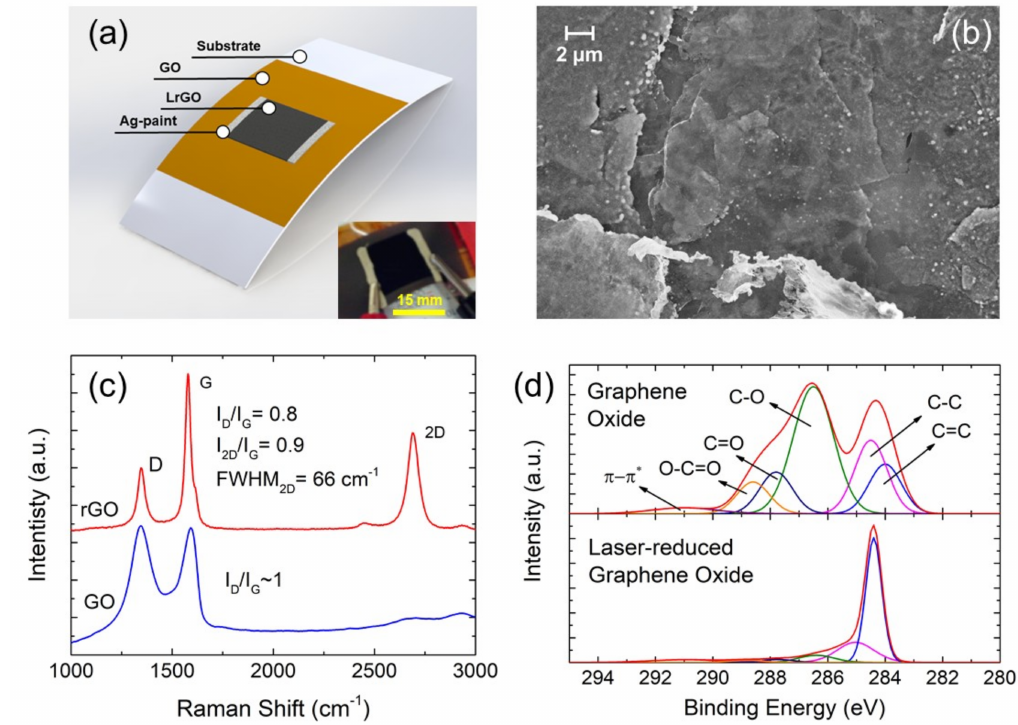
Figure 1. ( a ) Schematic diagram of the laser-reduced graphene-oxide (LrGO) heaters. Inset shows an actual picture of one of the LrGO heater (scale bar: 15 mm). ( b ), SEM image of a laser-reduced graphene oxide sheet [20]. ( c ) Raman spectra of both graphene oxide and laser-reduced graphene oxide. ( d ) X-ray photoelectron spectroscopy (XPS) high-resolution C 1 s peak of the graphene oxide before [20] and after the